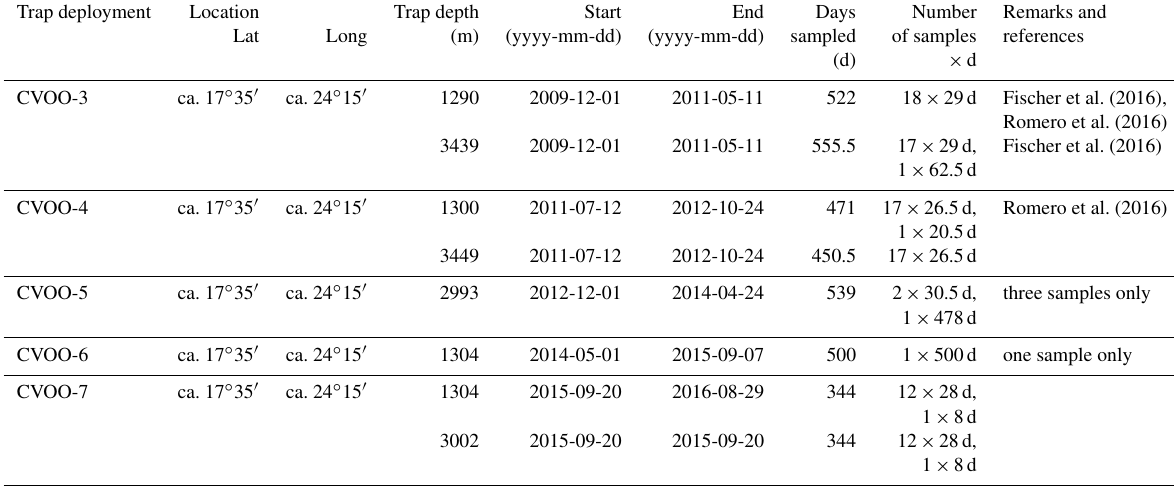
Table 1. Data of sampling with sediment particle traps at CVOO. Trap